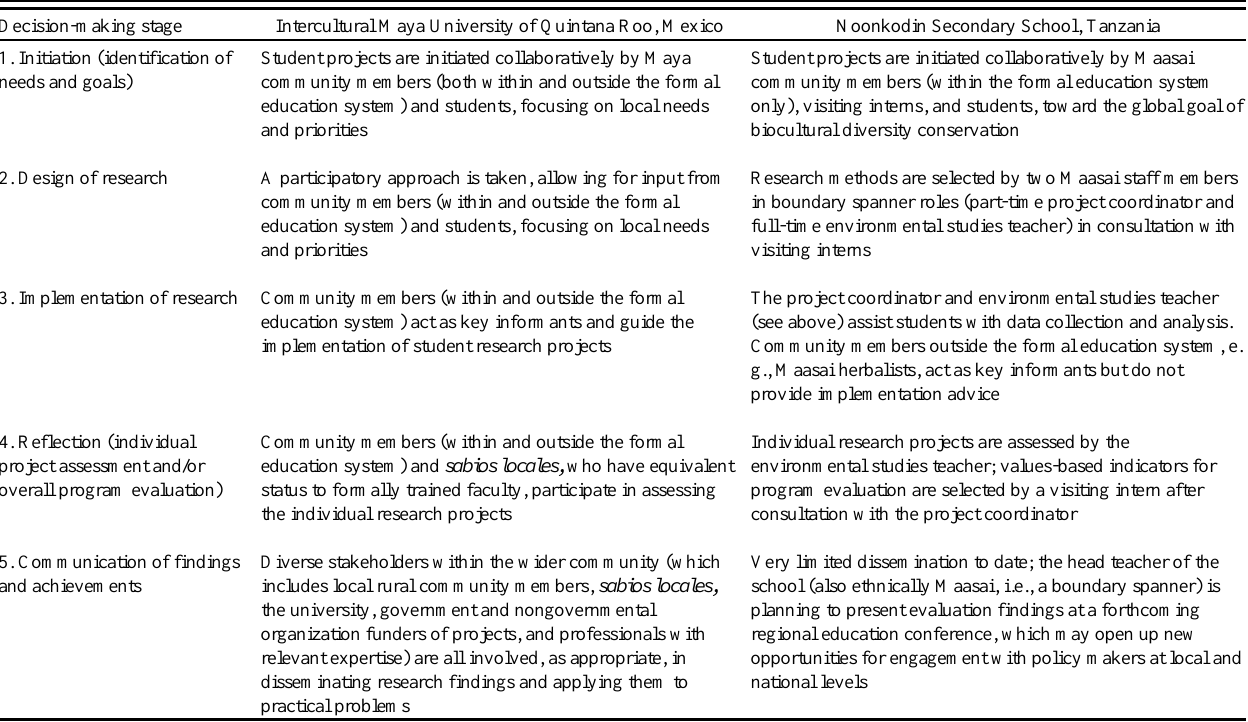
Table 2. Qualitative description of participation by indigenous stakeholders in students’ field research projects in Mexico and